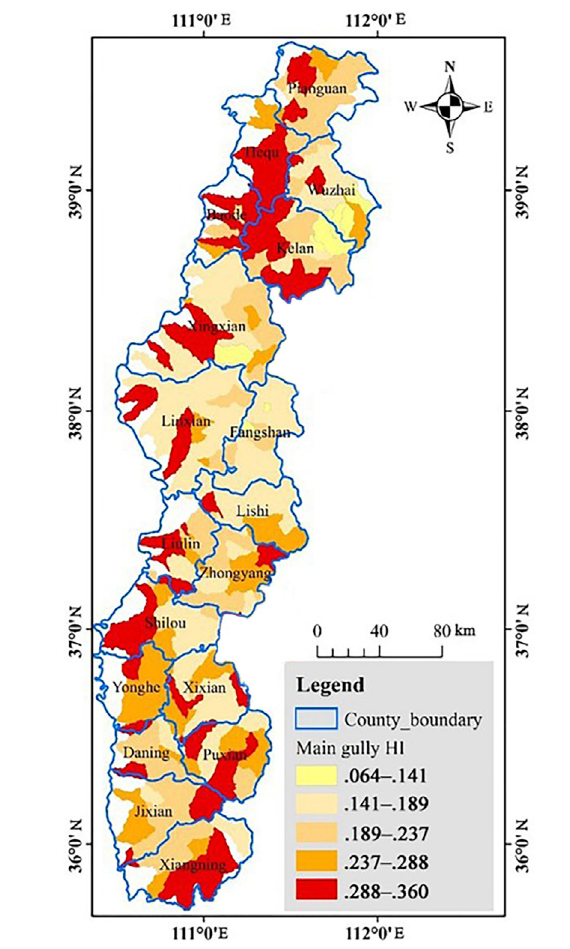
FIGURE 8 | Map of the spatial differentiation of the hypsometric integral (HI) of the main gully.